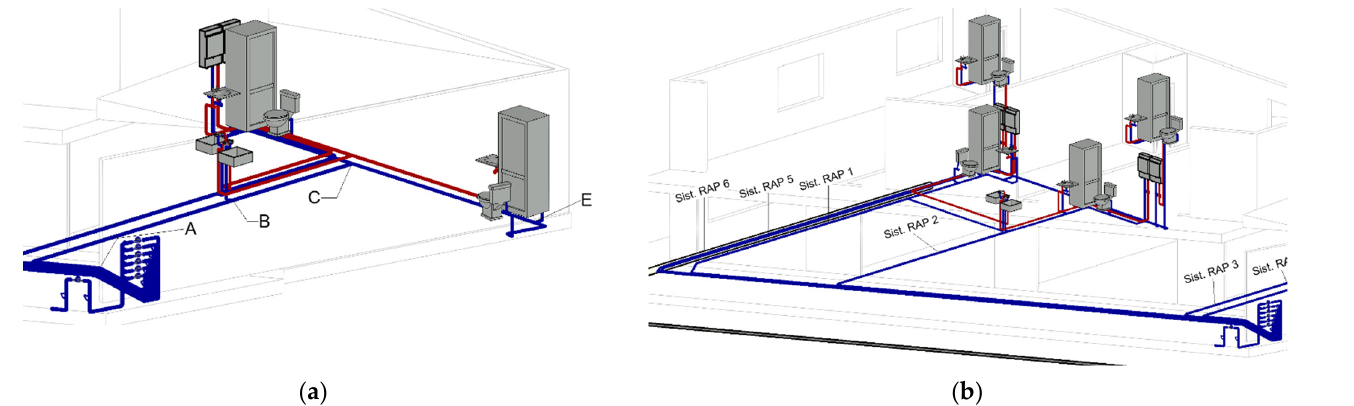
Figure 12 . Results of the application of scripts 3 and 4: ( a ) identification of nodes with the assignment of letters; ( b ) recognition of the drinking-water network system.